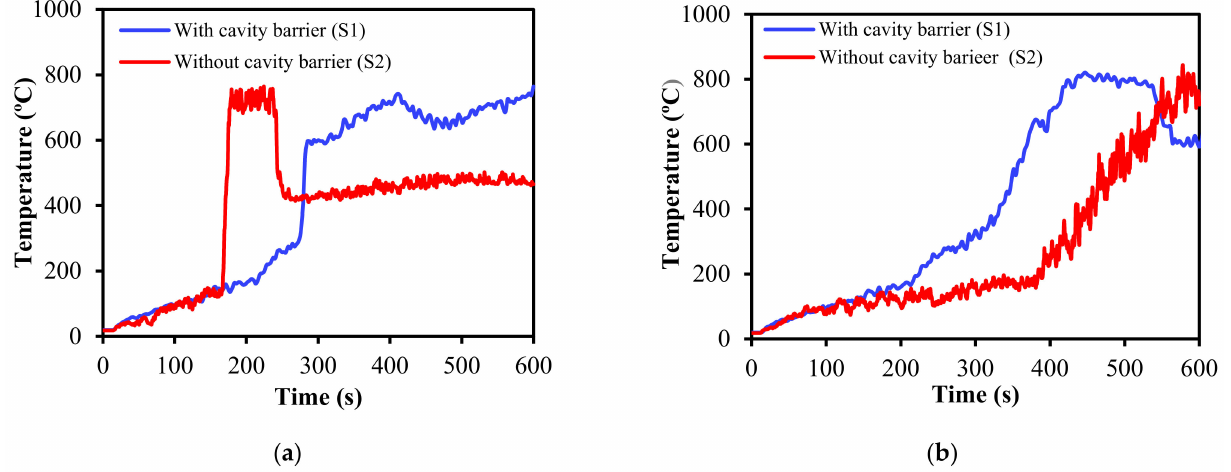
Figure 9. Effect of cavity barrier ( a ) internal temperature; ( b ) external